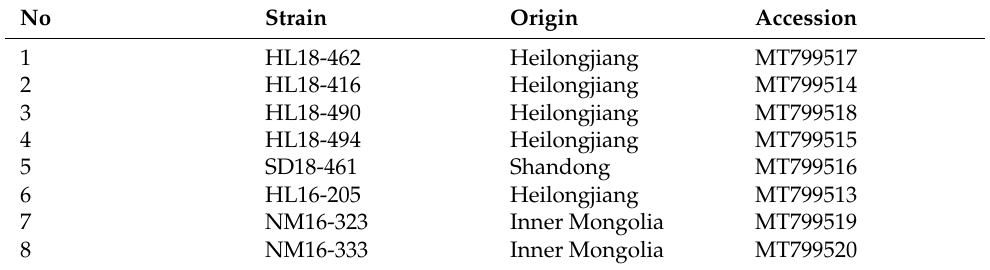
The phylogenetic tree of the complete genome of 8 new isolates along with 40 reference sequences (Table S3) was constructed and sequence identity were compared with other nine representative CSFV strains using the Clustal W method of Lasergene (Version 7.1) (Table 2). The genetic variations in E1, E2 and E rns proteins were investigated in detail by CLC Sequence Viewer 8.0, together with other reference isolates of CSFV. Table 2. New isolated strains of CSFV from China in this study based on the full-genome. No